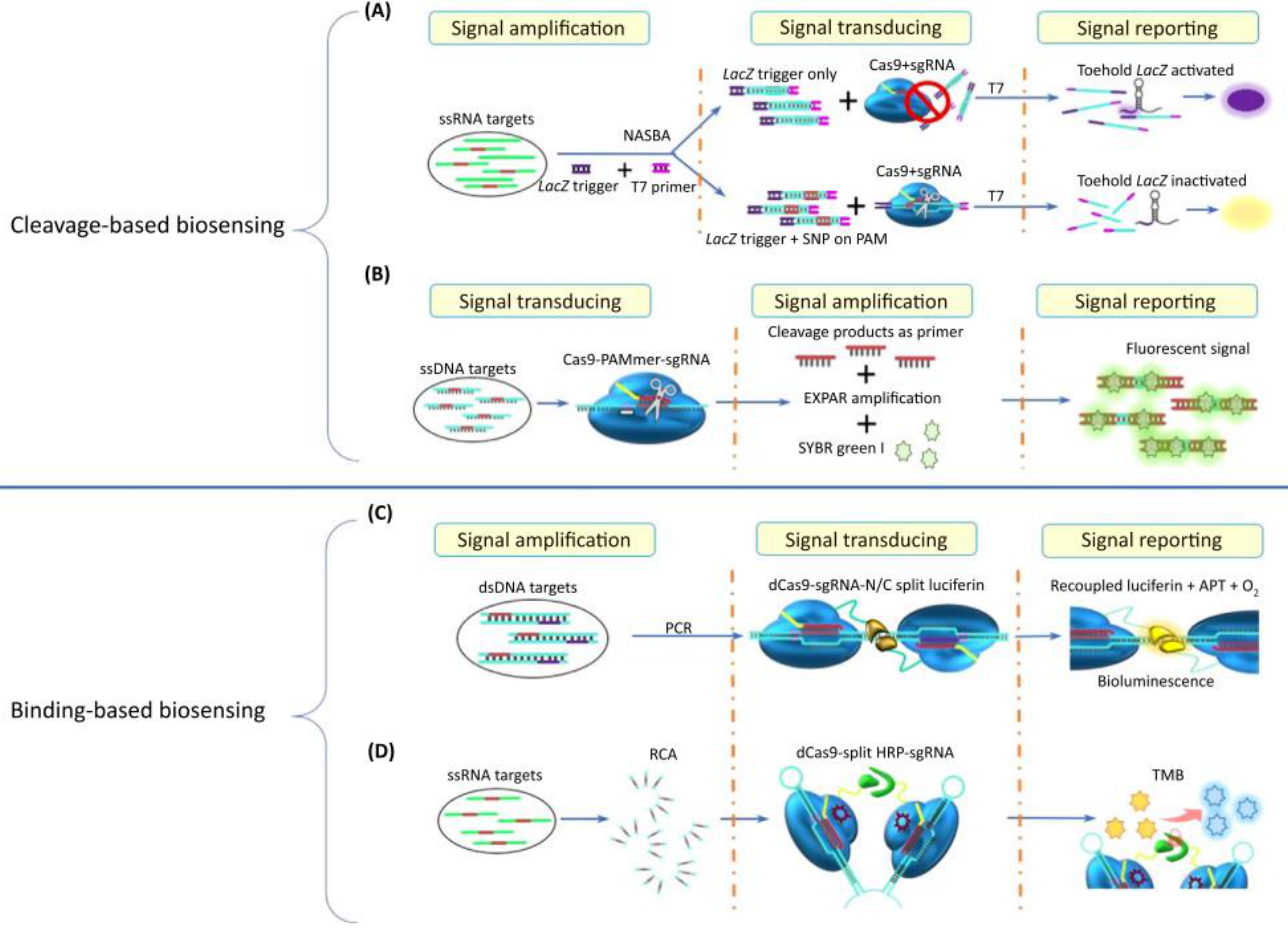
Figure 3. The use of CRISPR/Cas9 and dCas9 for the detection of diseases. (Reprinted with permission from Elsevier [79]. Copyright and Licensing.) The use of CRISPR/Cas9 for the detection of diseases can be classified into two approaches: ( A , B ): Cleavage-based biosensing. ( C , D ): Binding-based biosensing. ( A ). Nucleic Acid Sequence-based Amplification (NASBA)-CRISPR Cleavage (NASBACC). ( B ). CRISPR/Cas9 Triggered Isothermal Exponential Amplification (CAS-EXARP). ( C ). dCas9 conjugated to the split halves of luciferase, termed as paired dCas9 (PC) reporter. ( D ). Rolling Circle Amplification (RCA) for isothermal amplification of the target (microRNA), with dCas9 effectors fused together with split Horseradish Peroxidase (HRP).